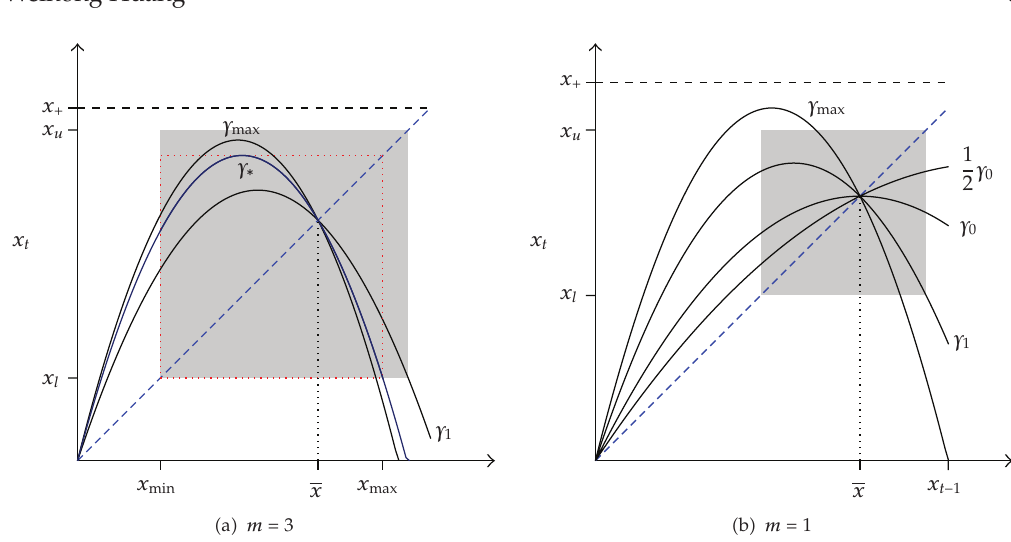
Figure 1: Illustration of x t (cid:6) f (cid:2) x t − 1 (cid:3) , relative profitability regime Ω p and the trapping set Ω(cid:2) γ (cid:3)